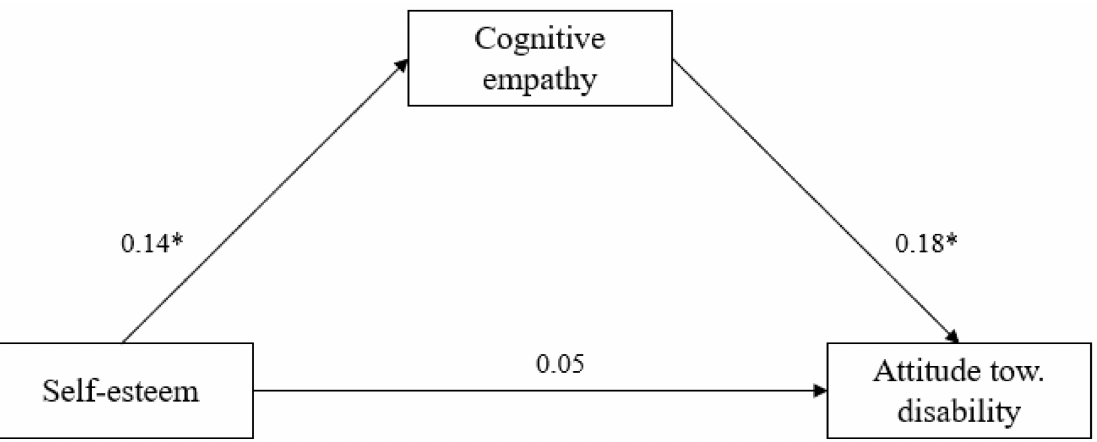
Figure 1. The indirect effect of cognitive empathy on the link between self-esteem and children’s attitudes toward disability ( N = 405). The values represent standardized coefficients. * p < 0.05.